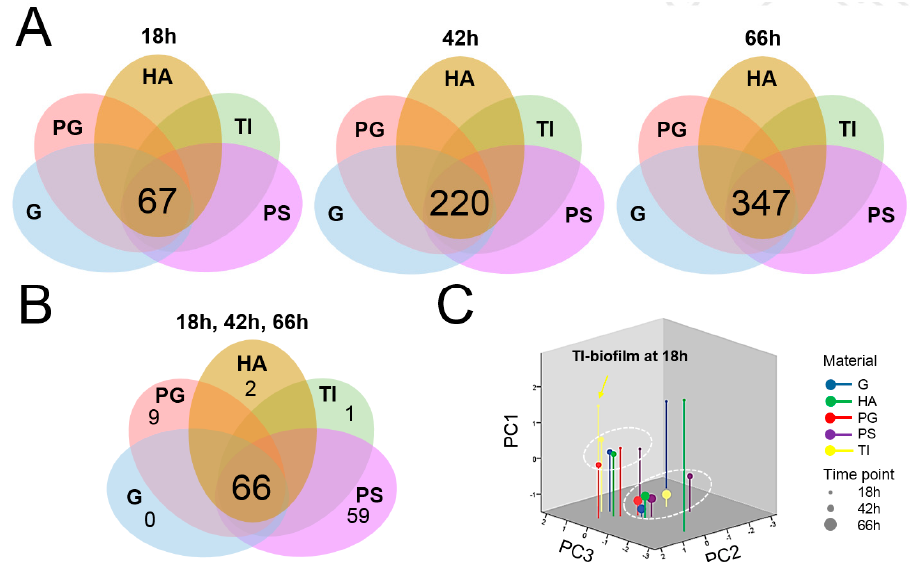
Figure 6. Venn diagrams representing the shared surfaceome proteins present on all materials at fixed time points of growth ( A ) and the number of all identified proteins shared by each biofilm and material combination and time point ( B ). A three-dimensional principle component analysis (3D PCA) analysis indicating outliers and clusters (circled) nested within the identified material- and time-dependent biofilm surfaceomes ( C ).